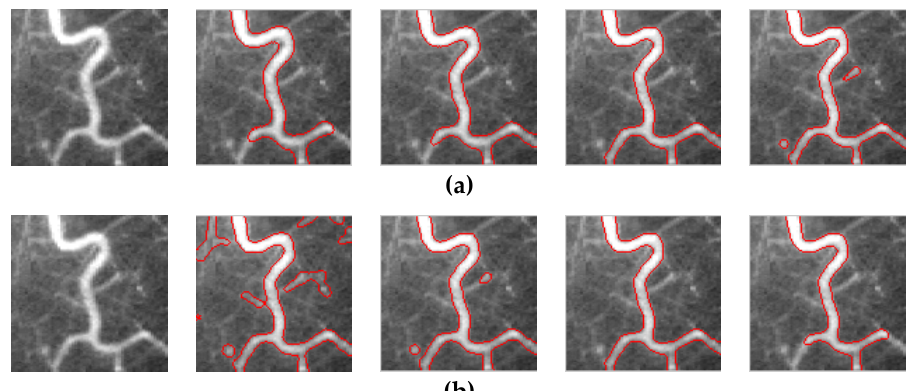
Figure 2. The segmentation results of a blood vessel using different parameter values: ( a ) The original image (left) and the segmentation results of our method with ν = 0.15 and different σ ; ( b ) The original image (left) and the segmentation results of our method with σ = 2.6 and different ν .